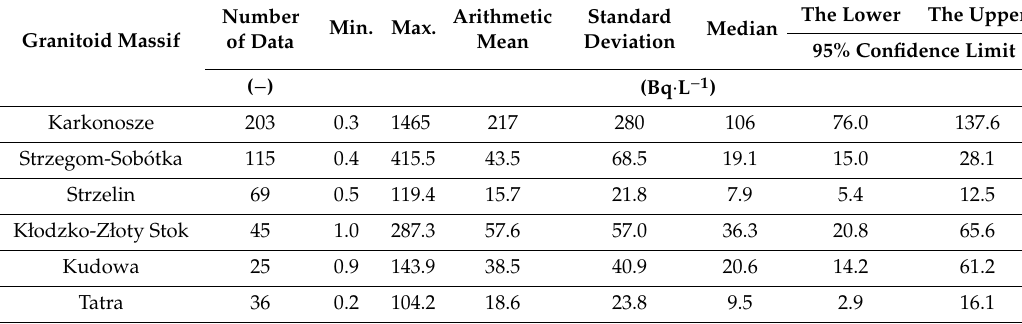
Figure 6. Kudowa granitoids. Groundwater sampling sites plotted together with the types of collected water by 222 Rn content according to Przylibski’s classification [2]. Table 1. Selected descriptive statistic values for 222 Rn activity concentration in groundwaters from granitoid massifs of